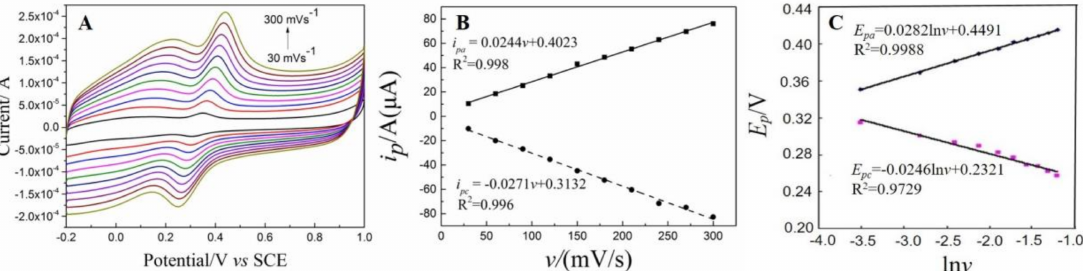
Figure 7. ( A ) CVs of 1 × 10 − 5 mol/L DA on the NH 2 –Fe 3 O 4 /RGO/GCE measured in 0.1mol/L phosphate buffer solution (PBS) at various scan rates ( v ); ( B ) Plot of redox peak currents ( i p ) versus scan rates ( v ); ( C ) Plots of redox peak potentials ( E p ) versus scan rates ( v ).